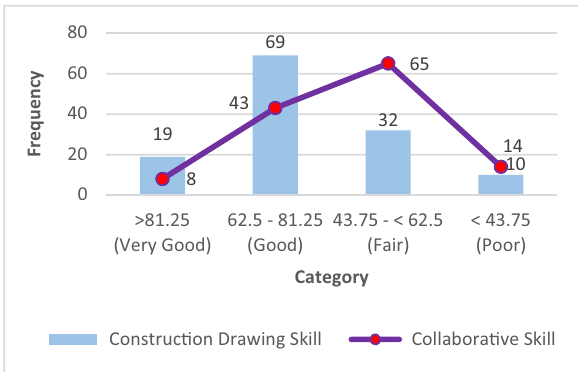
Figure 2: Frequency distribution of construction drawing skill and collaborative skill score.